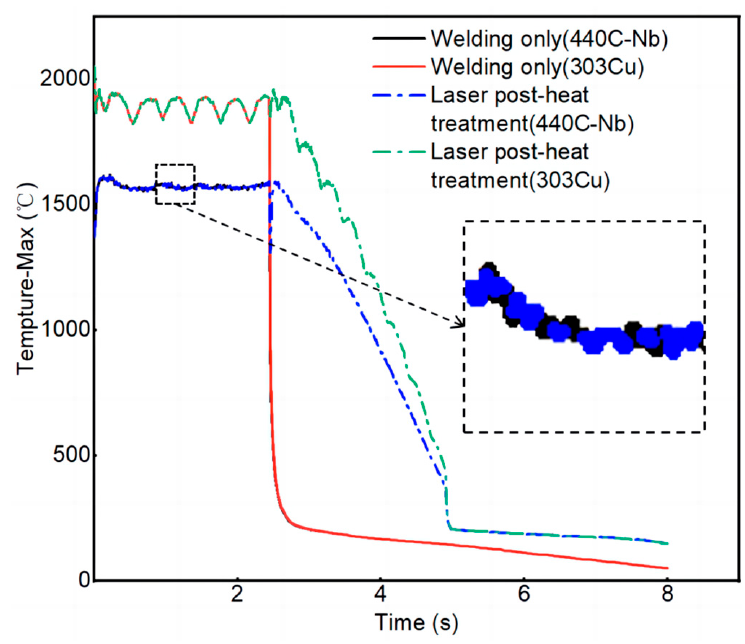
Figure 15. Maximum temperature history chart of different processes.